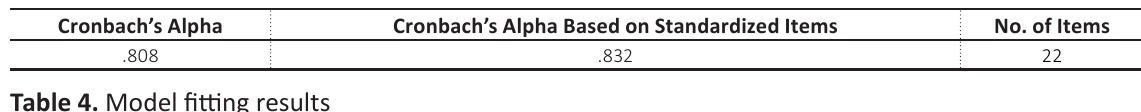
Table 3. Reliability